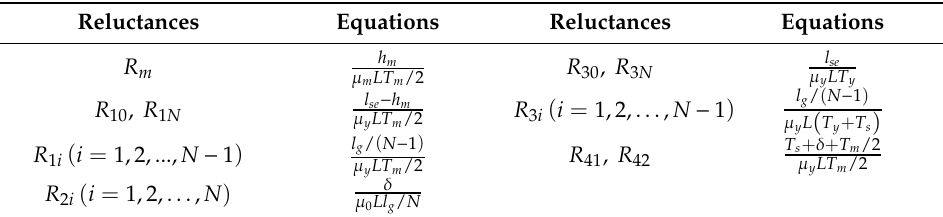
Table 1. Reluctance equations in the LPMEC model. Reluctances Equations Reluctances Equations R